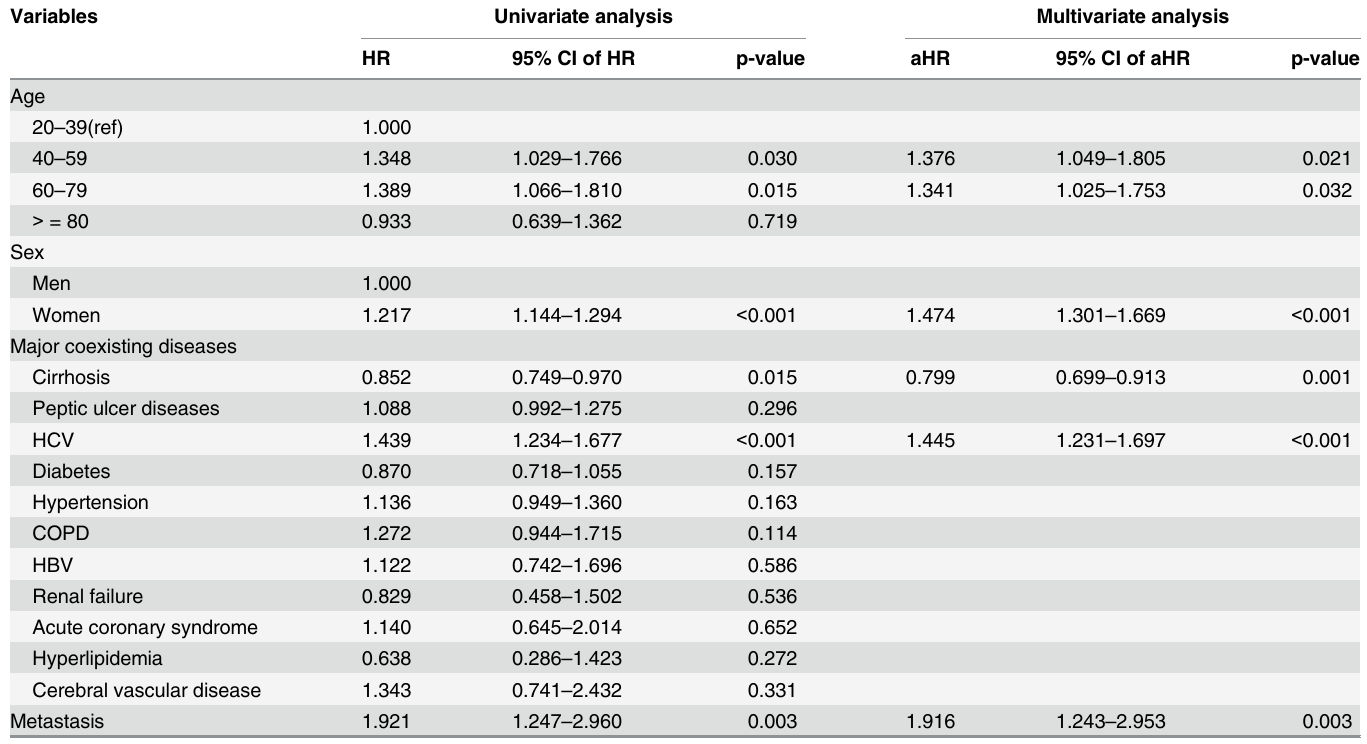
Table 3. Univariate and multivariate survival analysis for factors associated with depressive